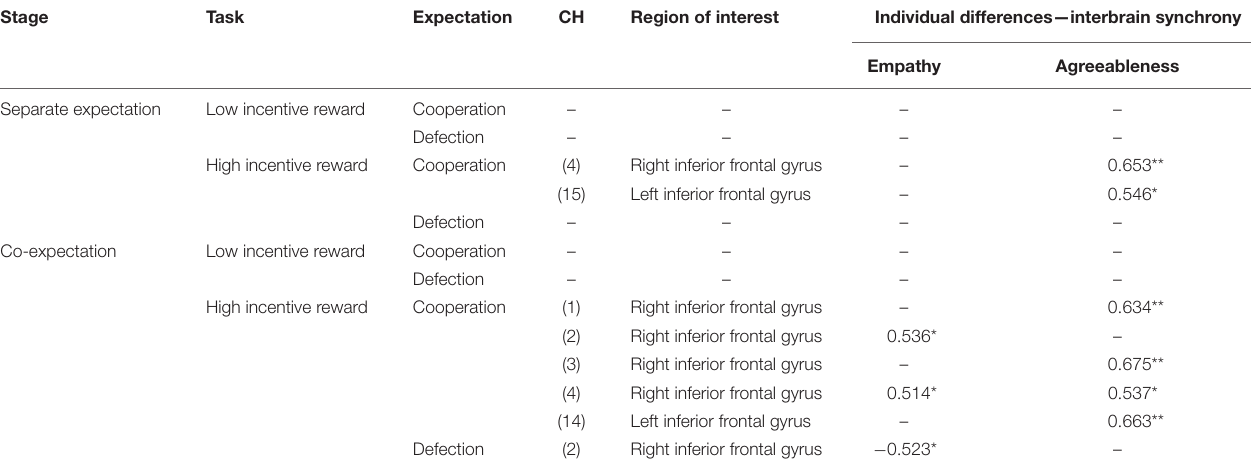
TABLE 3 | The neural–behavioral relation in all